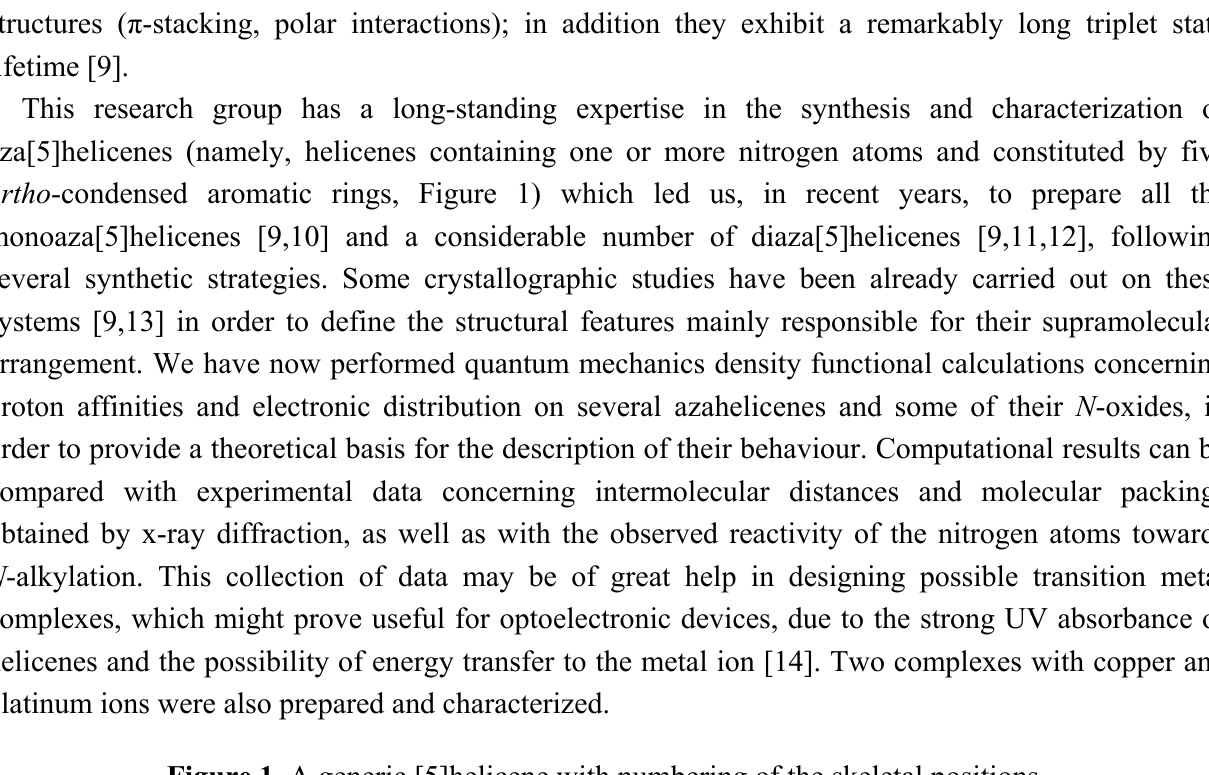
Figure 1. A generic [5]helicene with numbering of the skeletal